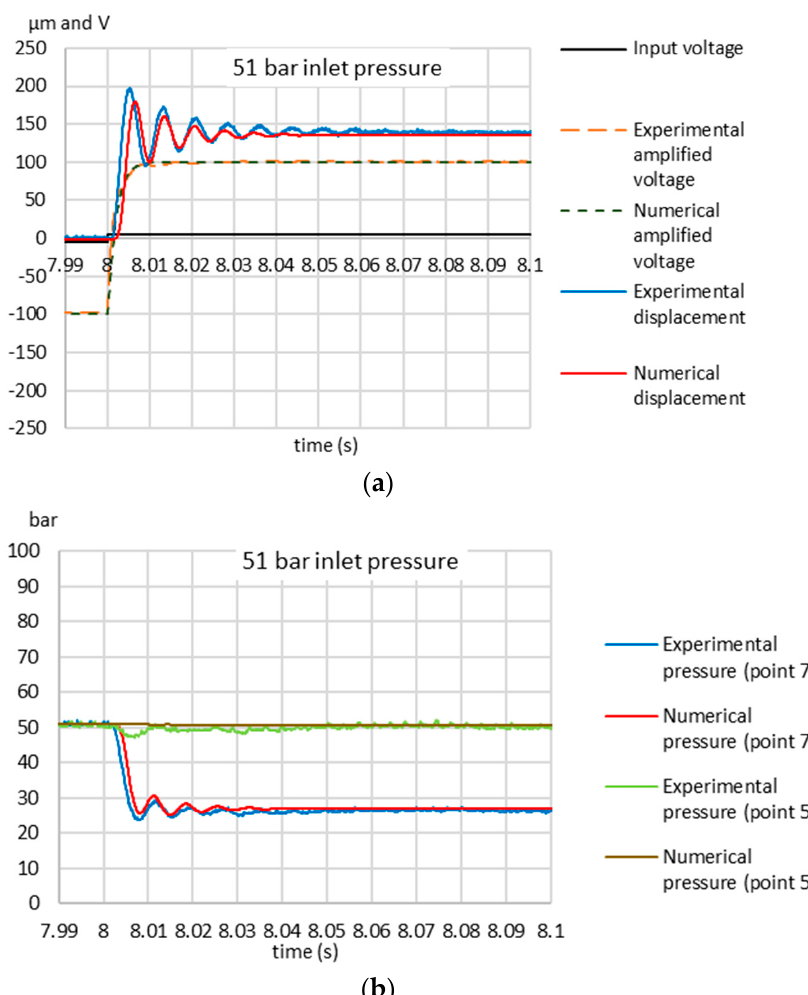
Figure 8. Test 4 (51 bar supply pressure). Comparison between measured amplified voltage and simulated one and between measured displacement and simulated one for a positive step control voltage (input voltage to the amplifier) from − 5 V to + 5 V: ( a ); comparison between measured pressures and simulated ones: ( b ) .